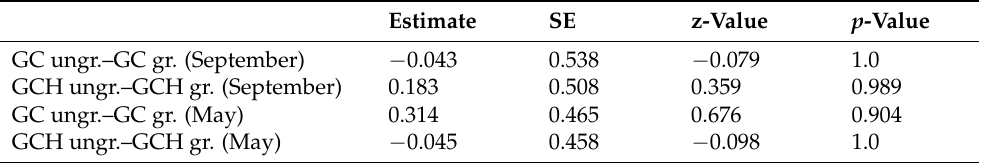
Table A28. Differences in activity densities of herbivore carabid beetles, comparing the grazed pastures and ungrazed strips of the grass–clover (GC) and the grass–clover herbs (GCH) in May/June and